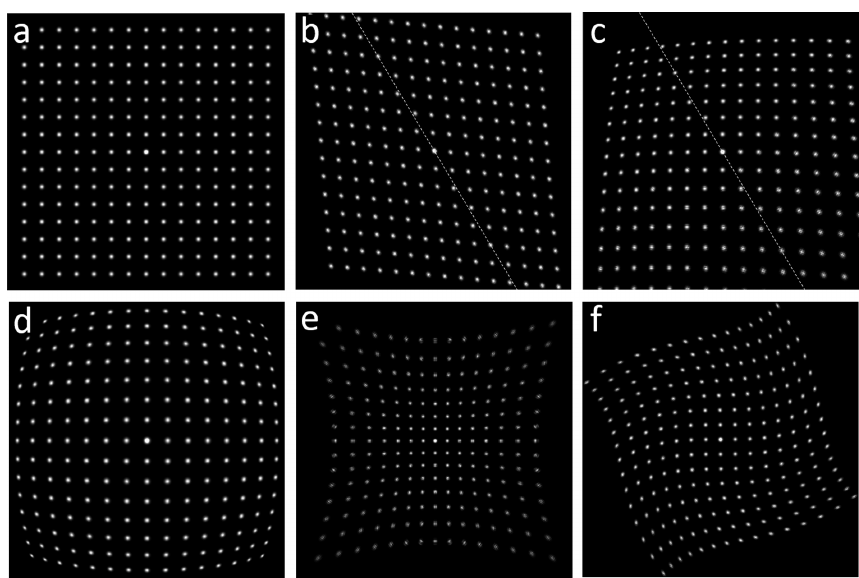
parameter, ( e ) pincushion with a positive (cid:3) 03